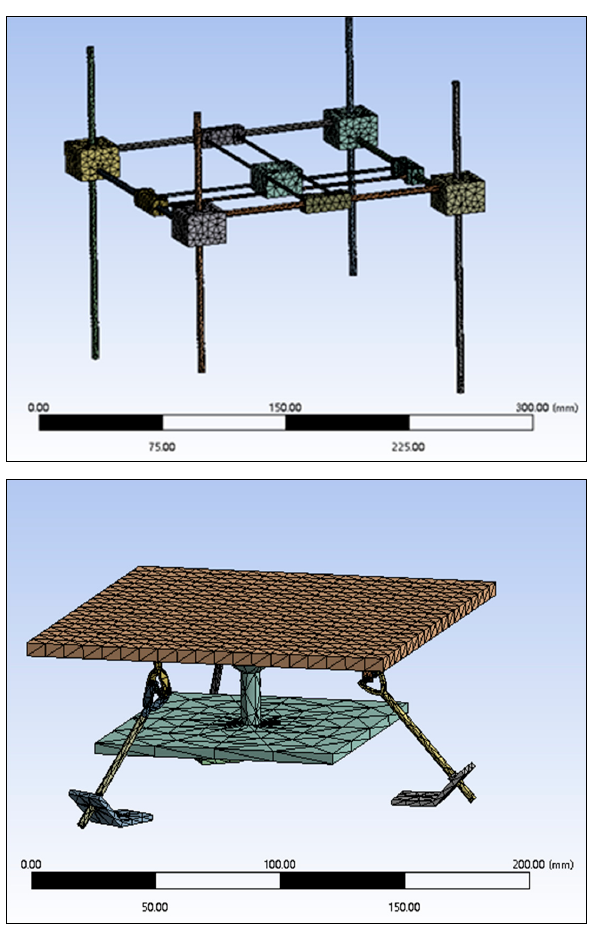
Figure 7. Meshing of kinematic mechanism of the ANSYS model.